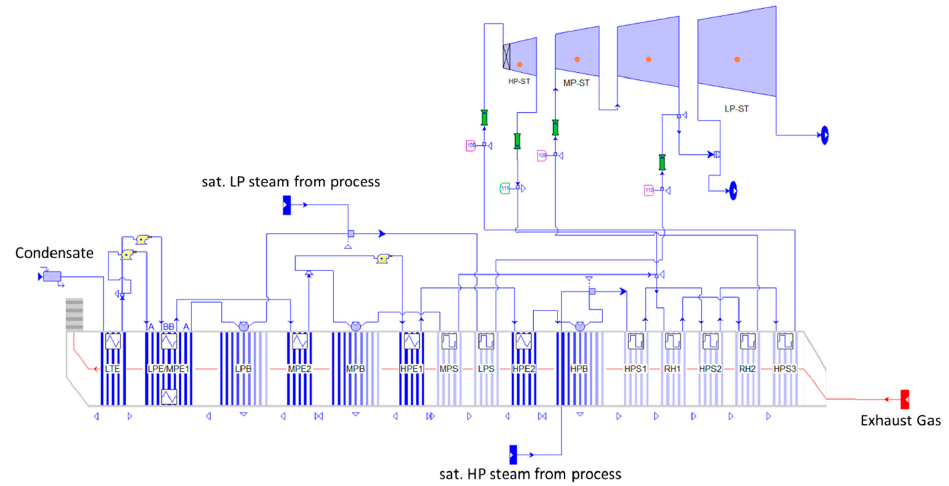
Figure 3. Schematic of the Heat Recovery Steam Generator (HRSG) and steam turbine (ST) system.